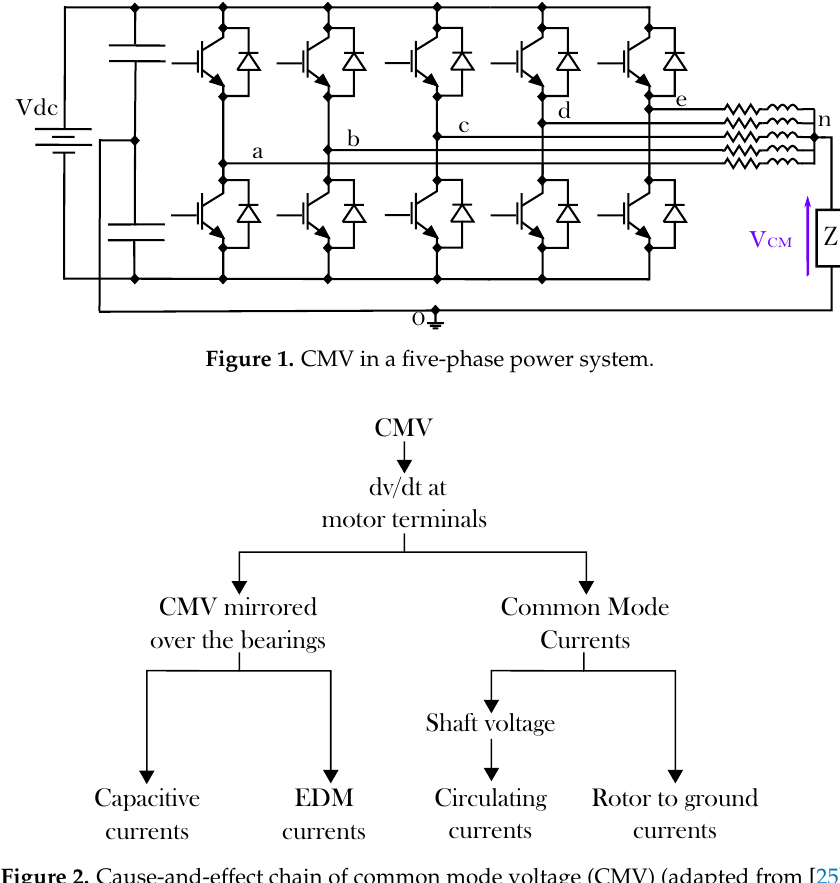
Figure 2. Cause-and-effect chain of common mode voltage (CMV) (adapted from